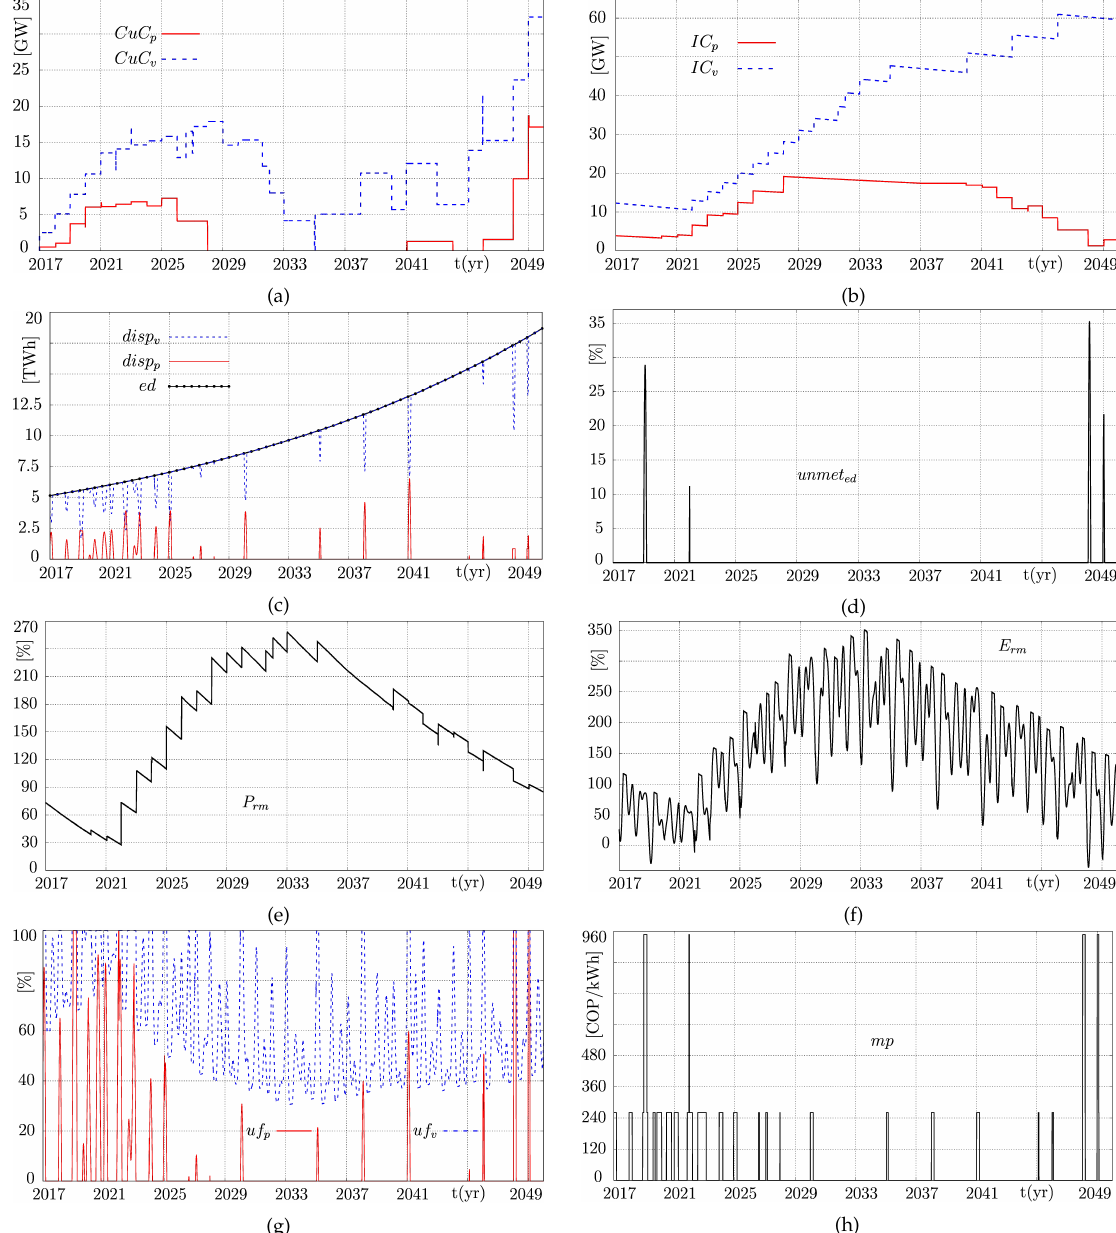
Figure 9. Simulation of the Colombian electricity market under seasonality and ENSO, considering the BaU scenario. ( a ) Capacity under construction (P) - CuC p and capacity under Construction (V) - CuC v , ( b ) installed capacity (P) - IC p and installed capacity (V) - IC v , ( c ) electricity demand - ed , dispatch (P) - disp p and dispatch (V) - disp v , ( d ) unmet ed - unmet ed , ( e ) power reserve margin - P rm , ( f ) energy reserve margin - E rm , ( g ) utilization factor (P) - uf p and utilization factor (V) - uf v , and ( h ) market price - mp